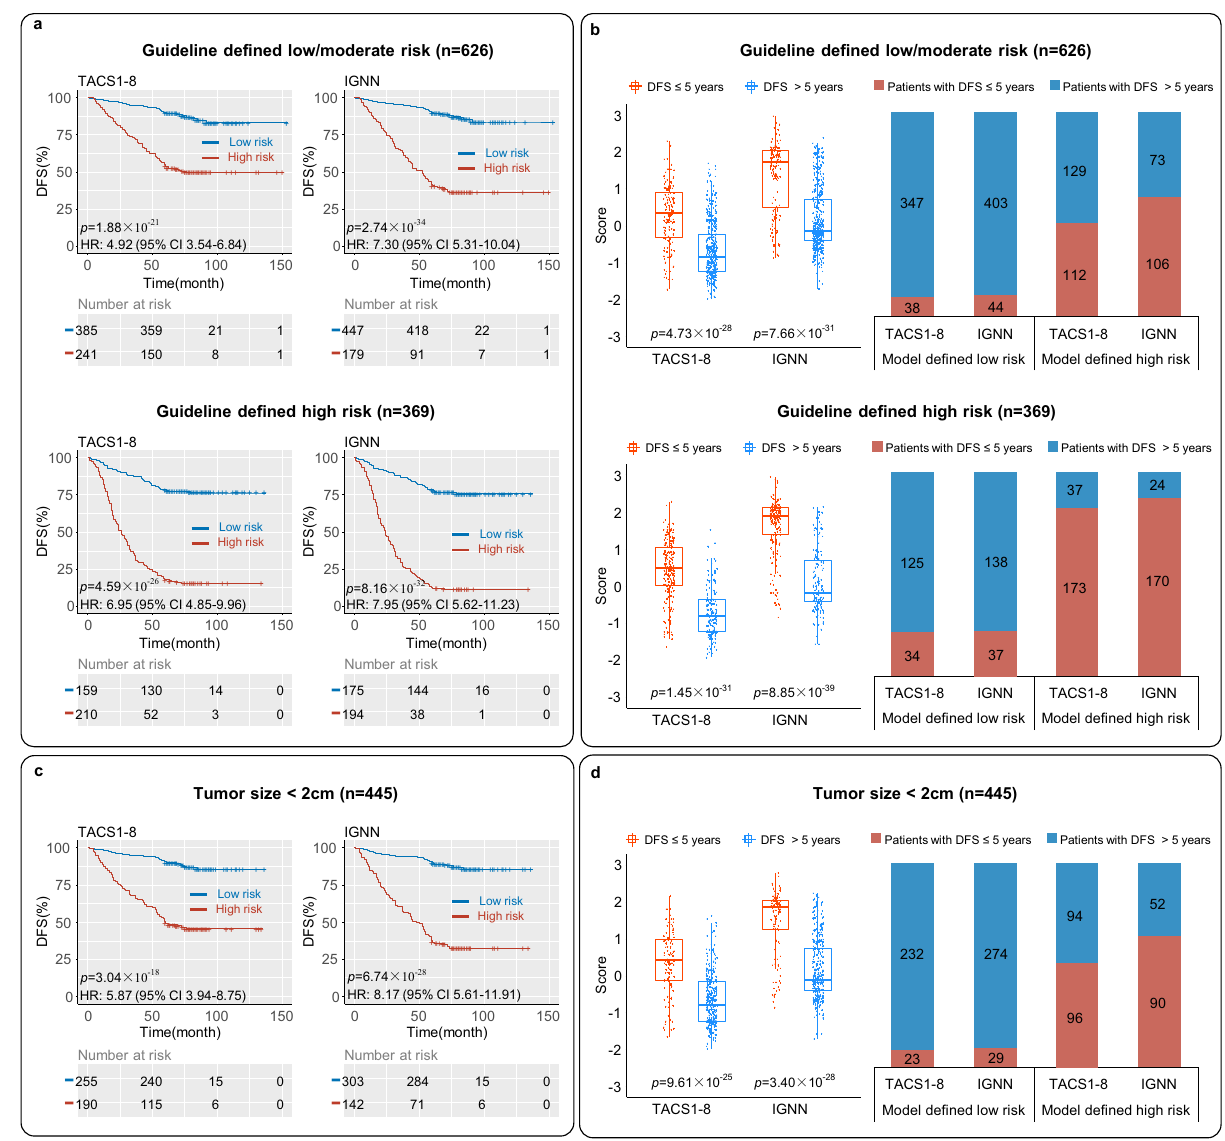
Fig. 3 Comparison between IGNN and TACS1-8 models in external validation. a Kaplan-Meier survival analysis of patients with the treatment guideline- derived low/moderate- and high-risk, re-strati fi ed into high (red line) and low risk group (blue line) based on two prognostic models. A two-sided log-rank test was performed to determine signi fi cance, showing HR values with con fi dence intervals and exact p values. b Corresponding boxplots (left panels) showing TACS and IGNN scores for patients with DFS less and more than 5 years (in boxplots, middle line represents the median value, the upper and lower boundaries of boxes indicate 25th and 75th percentile, the whiskers re fl ect 1.5 times of interquartile range, the upper and lower tails indicate the maxima and minima, and single points indicate the distribution of values. A two-sided unpaired t-test was used to compare risk subgroups and determine signi fi cance from exact p values), and percentage histogram (right panels) showing survival distributions for model-based risk subgroups indicative of undertreatment and overtreatment. c , d Similar information obtained from 445 patients with a small (<2 cm) tumor. HR hazard ratio, DFS disease-free survival, TACS (TACS1-8) tumor-associated collagen signatures, IGNN intratumor graph neural network. Source data are provided as a Source Data fi